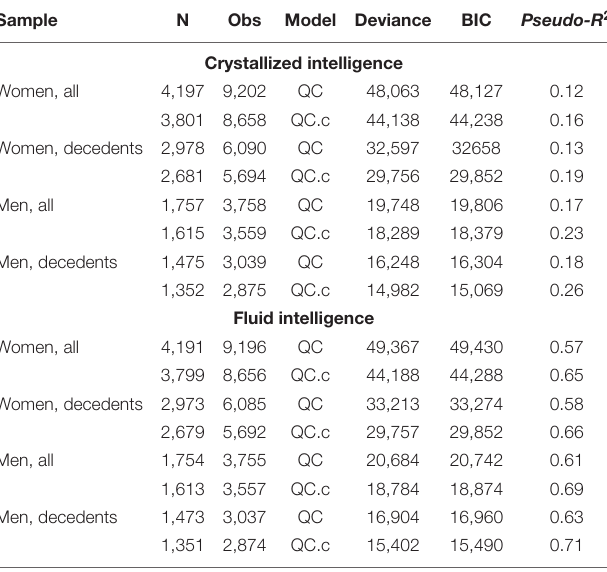
TABLE 2 | Fit statistics from multilevel models with quadratic change.